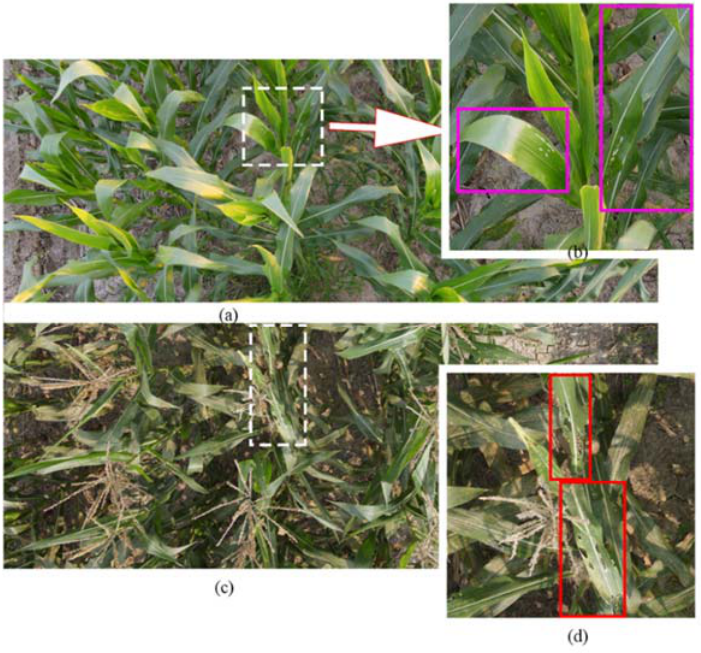
Figure 3. ( a , c ) Original images and ( b , d ) anchor boxes example for juvenile and severe severity de ‐ gree, respectively.